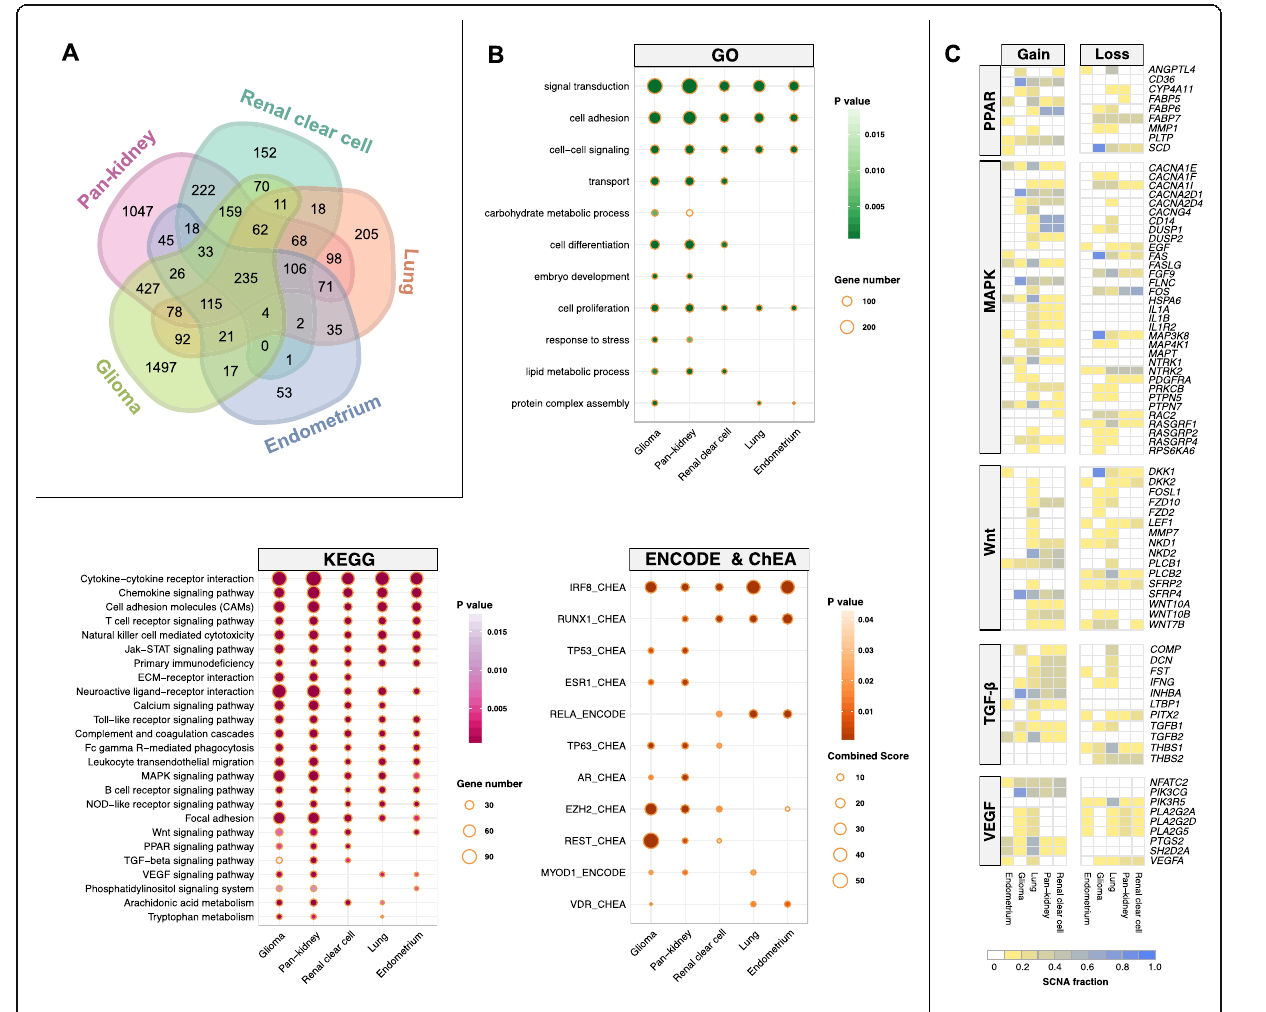
Fig. 4 Aberrant JAK-STAT signaling drives malignant progression through crosstalk with other oncogenic pathways. a Venn diagram depicts the number of overlapping differentially expressed genes (DEGs) in five cohorts. Differential expression analyses are performed between patients stratified into the 4th and 1st survival quartiles using the JAK-STAT signature in five cancer cohorts. b Functional enrichment analyses are performed by mapping DEGs to the Gene Ontology and KEGG databases. Mapping of DEGs to ENCODE and ChEA databases identify enriched transcription factor binding associated with DEGs. c Somatic copy number alteration frequencies for DEGs identified from enriched pathways in B. Heatmaps depict the fraction of somatic gains and losses for DEGs found within five oncogenic pathways. Only genes that are altered in more than 10% of samples within each tumor type are